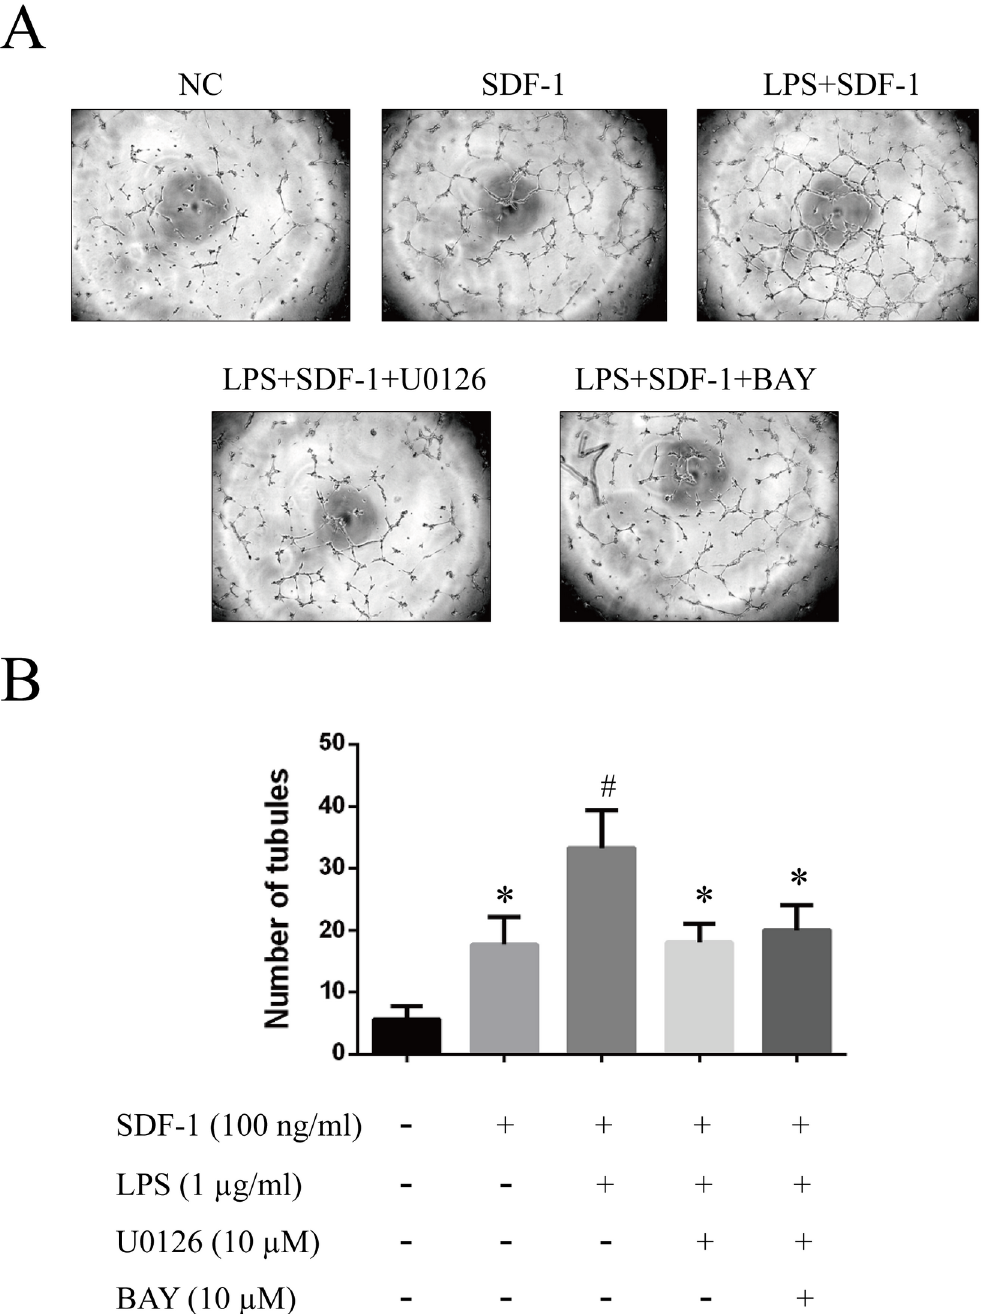
Fig 6. Effects of LPS on SDF-1-induced RF/6A cell tube formation. Networks of tube-like structures were measured in a blinded manner. Representative images of tube-like structures are given: untreated ( A ); SDF-1 (100 ng/ml) alone in the lower chamber ( B ); LPS (1 μ g/ml) pretreatment plus CXCL12 (100 ng/ ml) in the lower chamber ( C ); combined LPS and U0126 pretreatment plus SDF-1 in the lower chamber ( D ); combined LPS and BAY 11 – 7082 pretreatment plus SDF-1 in the lower chamber ( E ). ( F ) Quantitative analysis of the number of tubules, expressed as the mean ± SD. Statistical significance determined using one-way ANOVA with * P < 0.05, ** P <